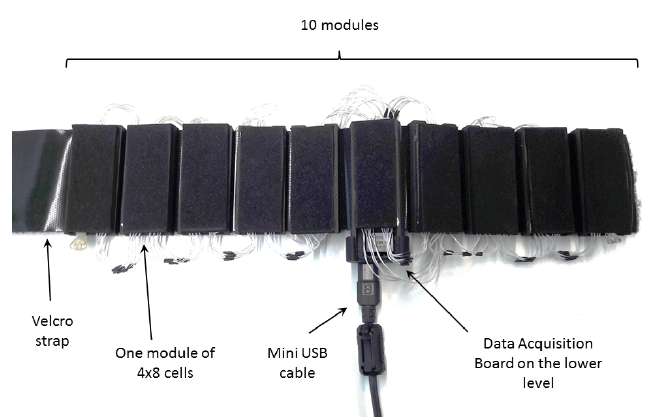
Figure 3. The tactile bracelet rolled out with 10 modules regularly spaced on a Velcro